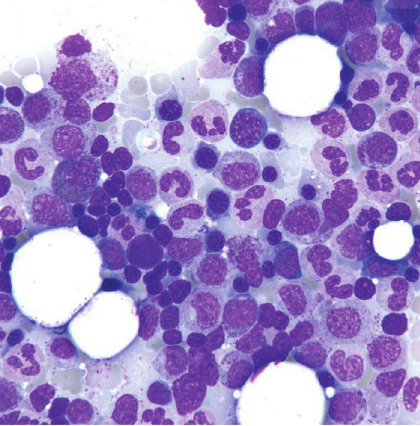
Figure 5: Bone marrow aspirate with normal erythropoiesis (Wright-Giemsa, original magnification × 100).